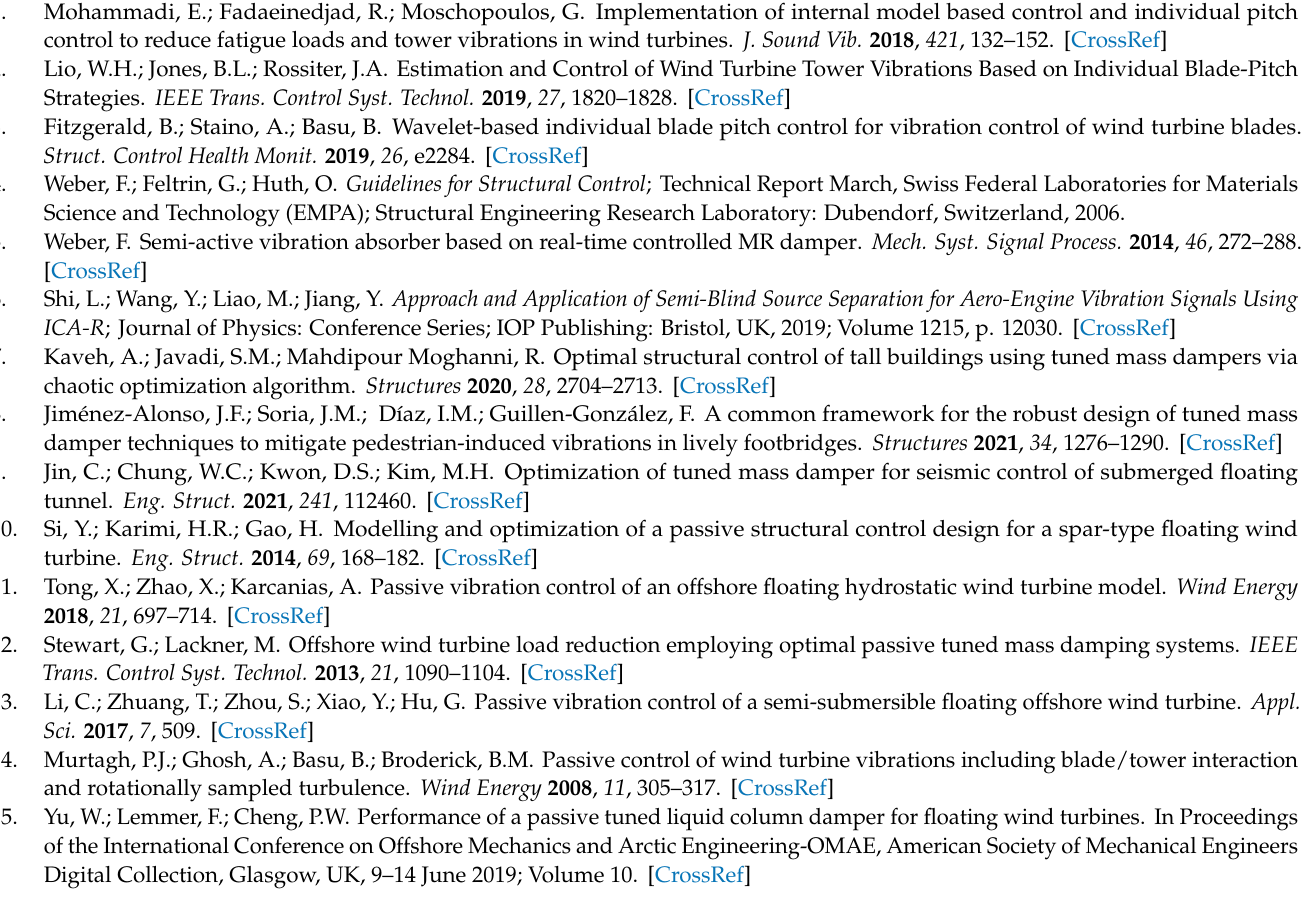
Figure A5. Tower-top fore-aft deflection and status of TRD in EOG with grid loss at V rate dependency is omitted in